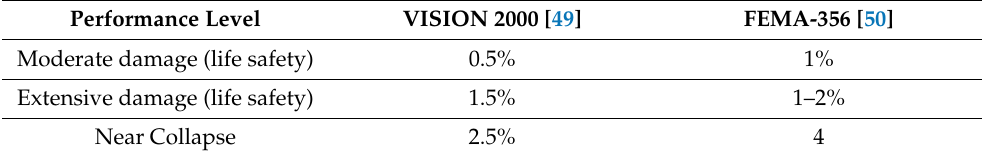
Table 3. Performance levels and corresponding maximum limit